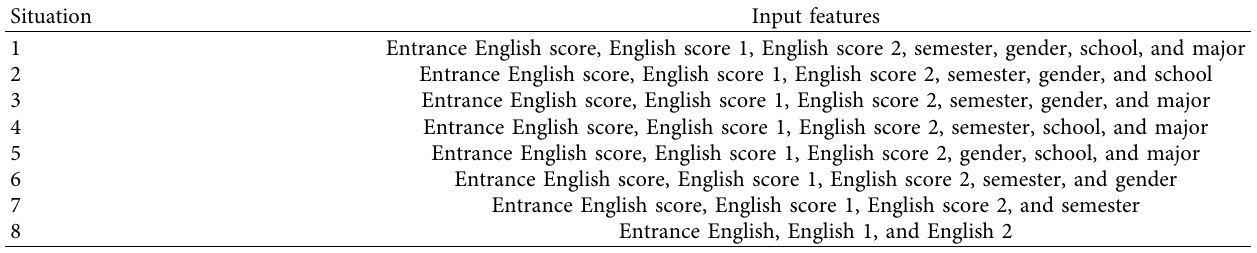
Table 3: Input characteristics.